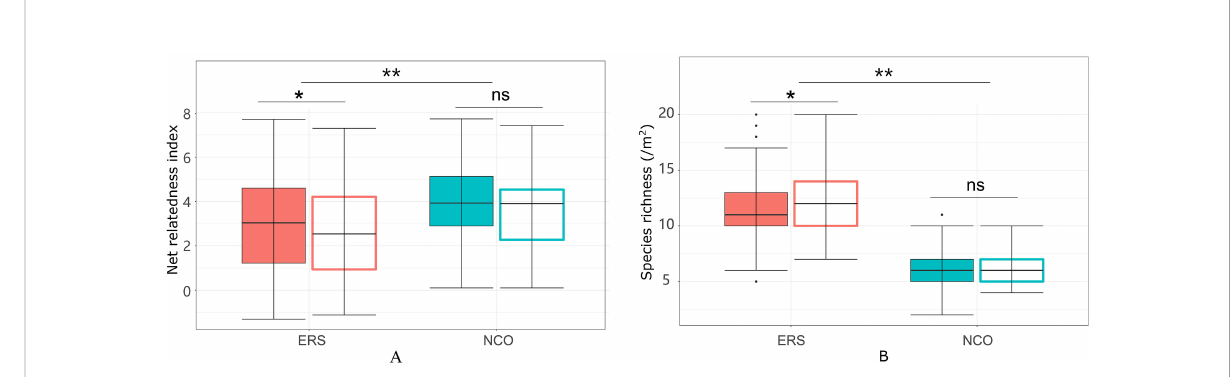
FIGURE 3 Net relatedness index (A) and species richness (B) at the Inner Mongolia Grassland Ecosystem Research Station (ERS) and Xilinhot National Climate Observatory (NCO) in Inner Mongolia, China. Filled boxes indicate annual mean NRIs (or species richness), and empty boxes indicate peak growing season NRIs (or species richness). A single asterisk and double asterisk indicate p < 0.05 and p < 0.01, respectively, according to Duncan ’ s post hoc test. ns, not signi fi